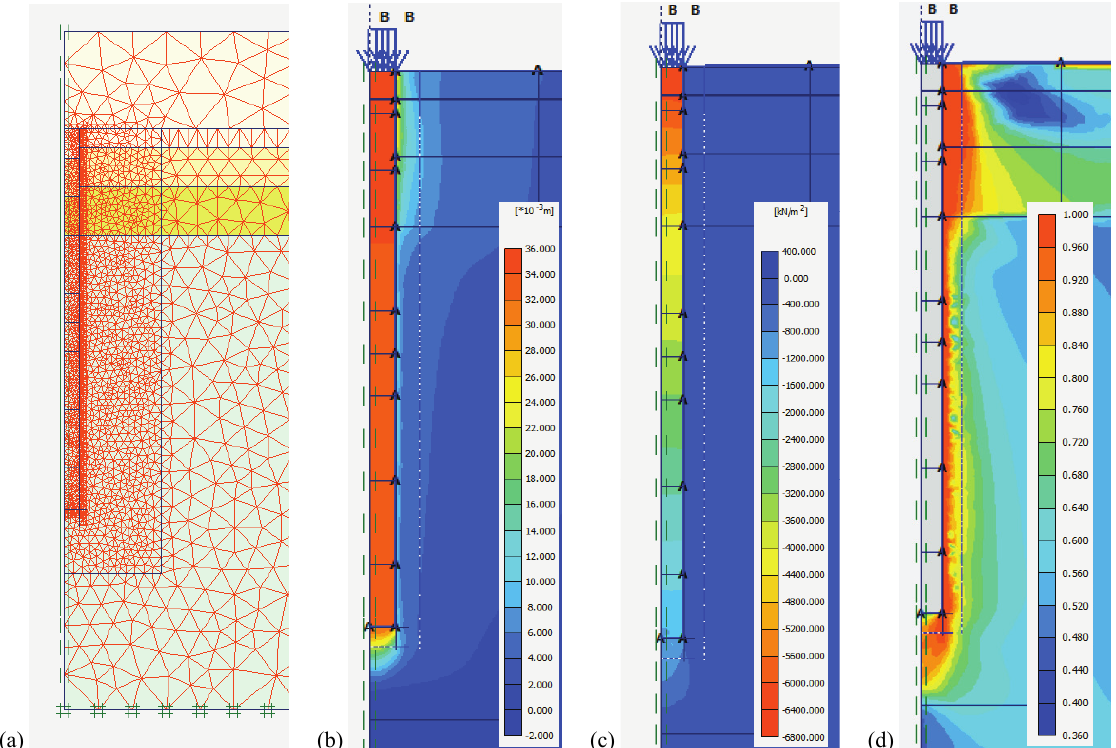
Fig. 6. Screens from Plaxis software: (a) generated mesh, (b) total displacement, (c) vertical effective stress, (d) relative shear stress